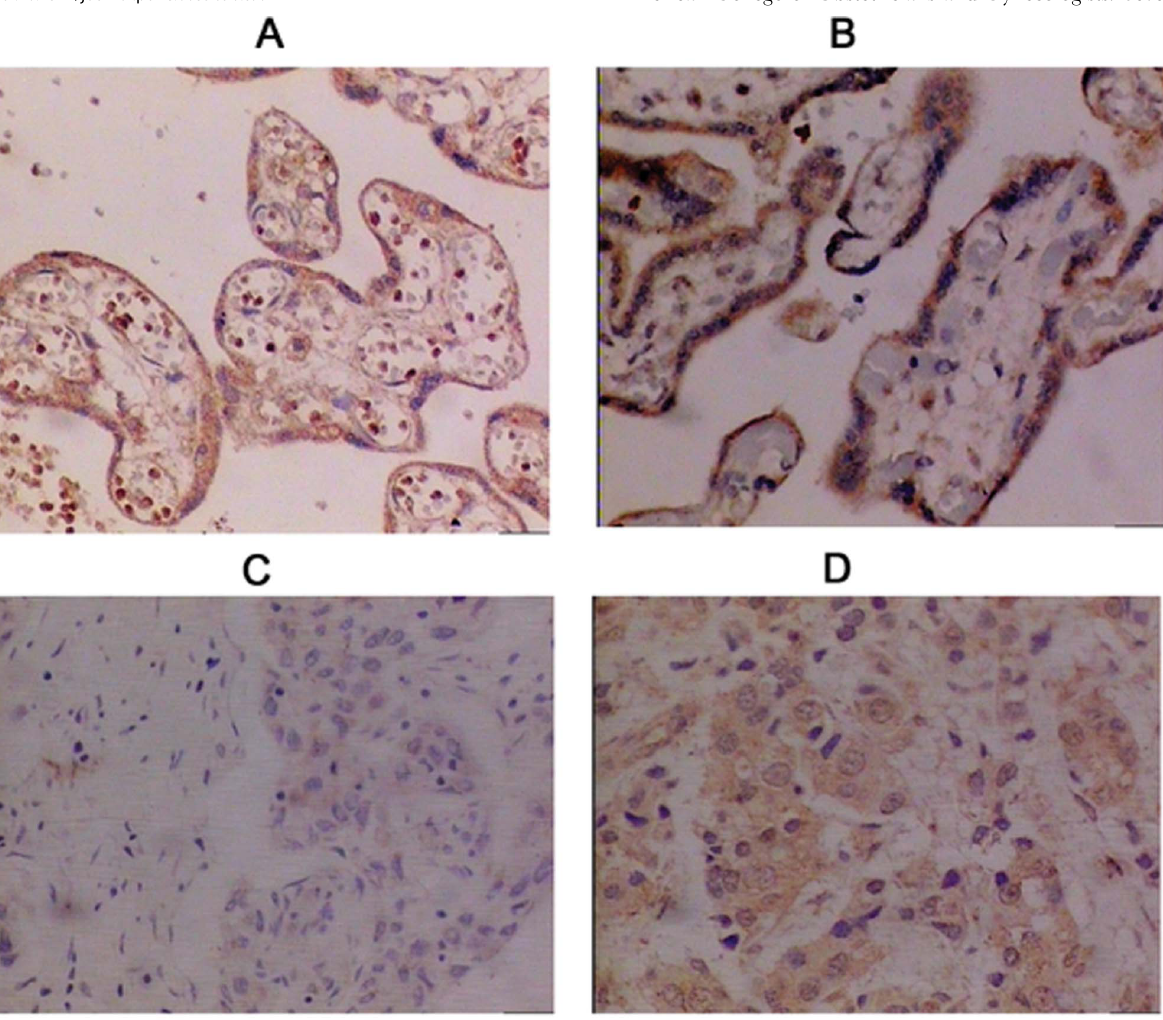
Figure 1. Placental expression of Foxp3 in normal and PE groups. Figure 1A PE group placental trophoblast showed Foxp3 positive cells in immunohistochemical staining 6 200. Figure 1B Control group placental trophoblast showed Foxp3 positive cells in immunohistochemical staining 6 200. Figure 1C PE group placenta decidua showed Foxp3 positive cells in immunohistochemical staining 6 200. Figure 1D Control group decidual cells showed Foxp3 positive cells by immunohistochemical staining 6 200.